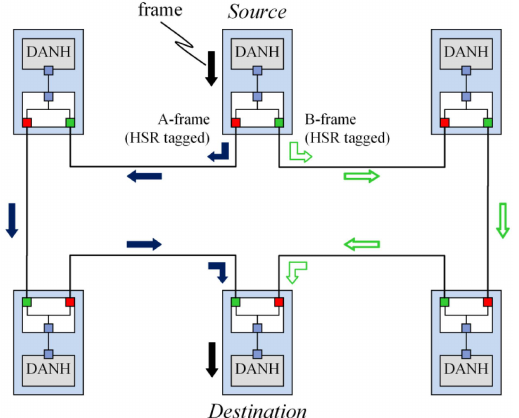
Figure 1. High-Availability Seamless Redundancy (HSR) example of single-ring topology for unicast traffic.